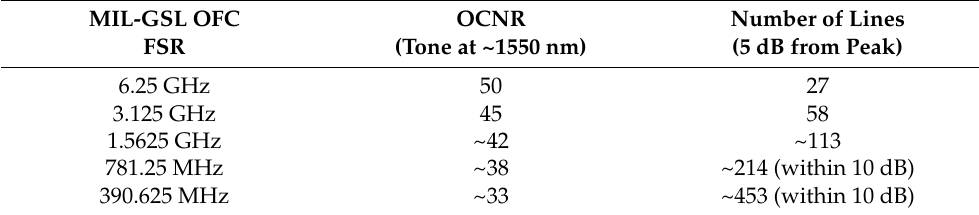
Table 3. Summary of the MIL-GS OFC comb